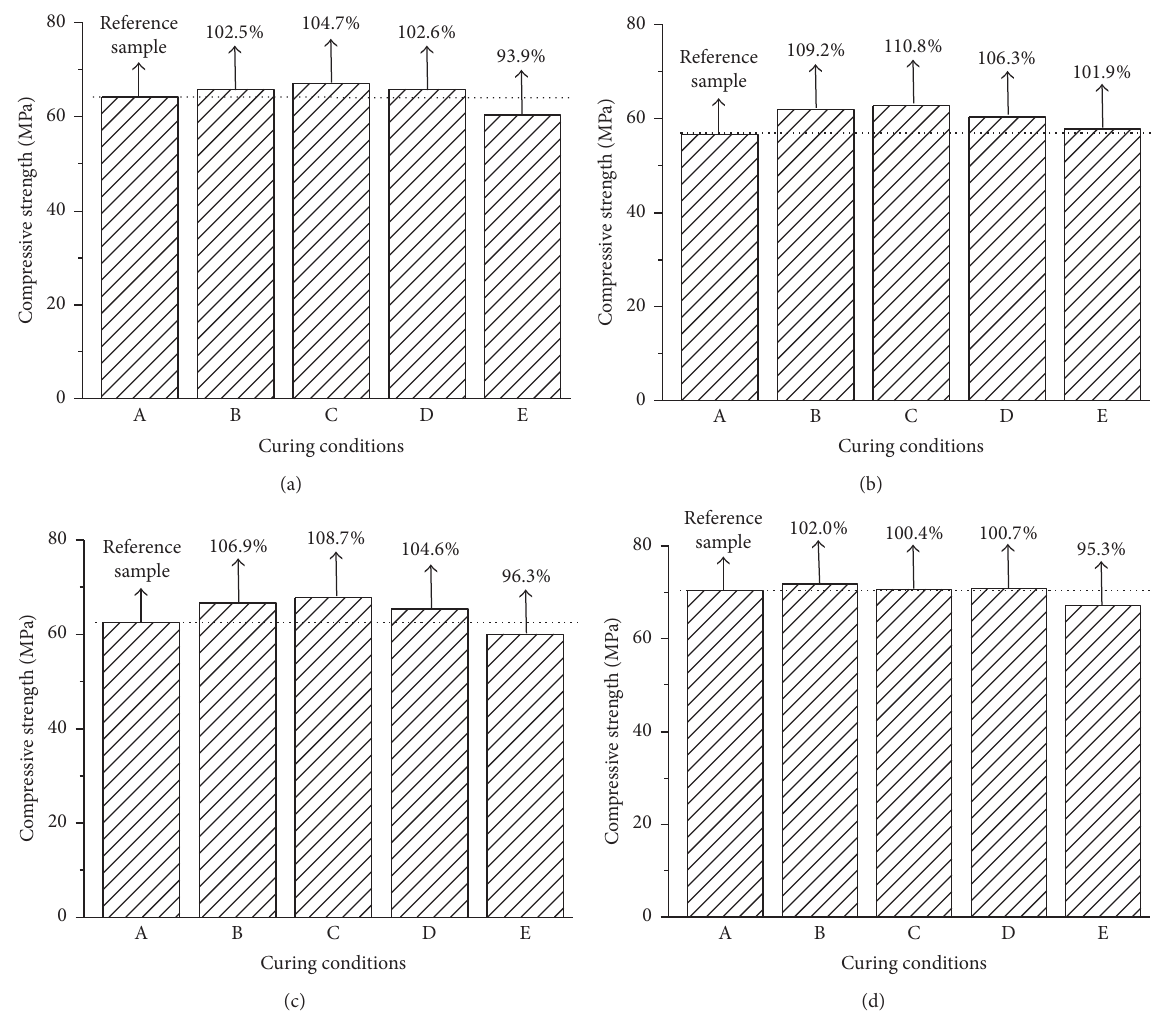
Figure 4: Compressive strengths of the concretes cured under different curing conditions at the age of 90 days. Samples: (a) plain cement, (b) 45% FA, (c) 45% GGBS, and (d) 12%